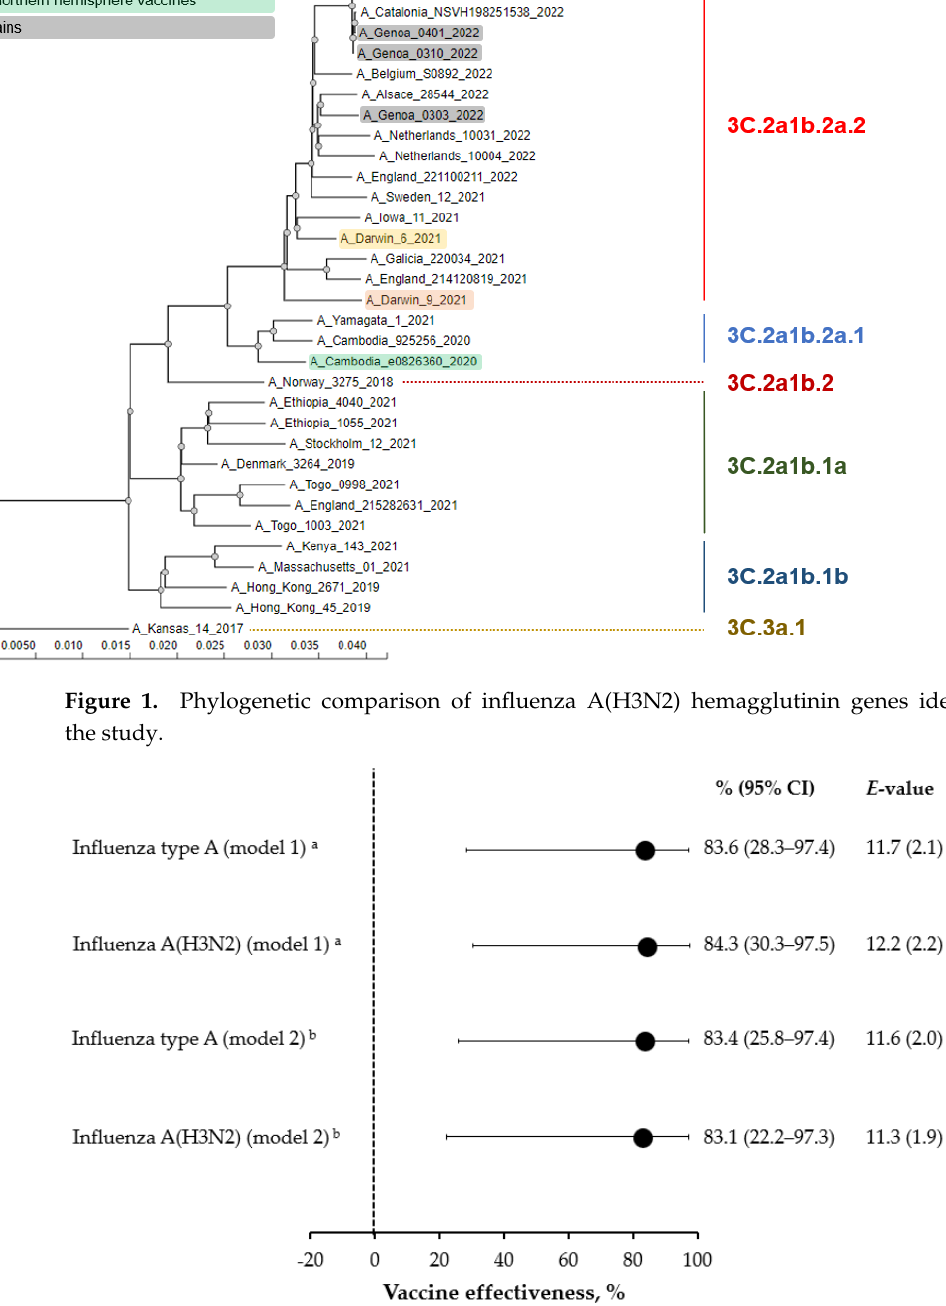
Figure 2. Effectiveness of the 2021/22 seasonal influenza vaccination against severe acute respiratory infection. a Covariates (age, area, month of symptom onset, COVID-19 vaccination pattern and previous season influenza vaccination) selected on the basis of minimization of the corrected Akaike’s information criterion; b Fully adjusted (age, sex, area, month of symptom onset, swab delay, presence of chronic conditions, COVID-19 vaccination pattern, and previous season influenza vaccination) model.